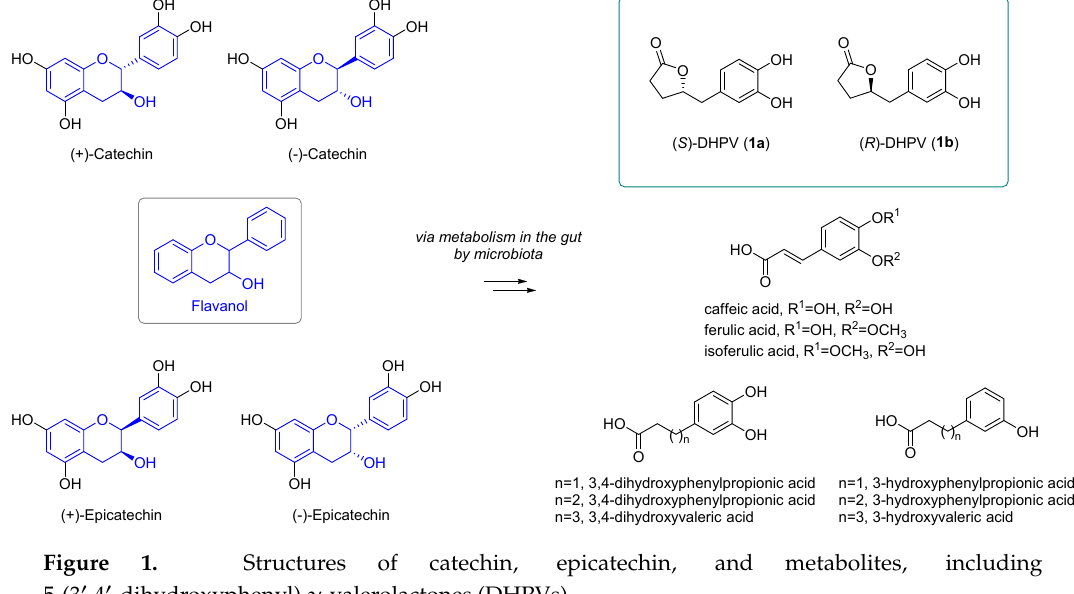
Figure 1. Structures of catechin, epicatechin, and metabolites, including 5-(3 ′ ,4 ′ -dihydroxyphenyl)- γ - 1. Structures of catechin, epicatechin, and metabolites, including valerolactones (DHPVs). 5-(3 (cid:48) ,4 (cid:48) -dihydroxyphenyl)- γ -valerolactones